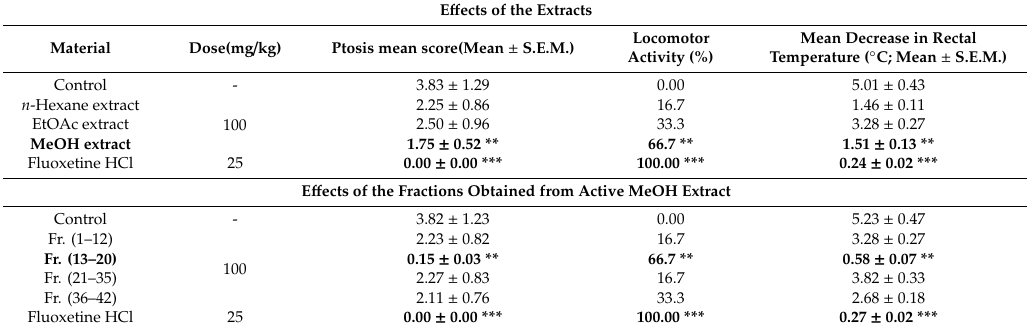
Table 4. E ff ects of the extracts and fractions prepared with organic solvents from Lotus corniculatus L. subsp. corniculatus in the antagonism of tetrabenazine-induced ptosis, hypothermia and suppression of locomotor activity